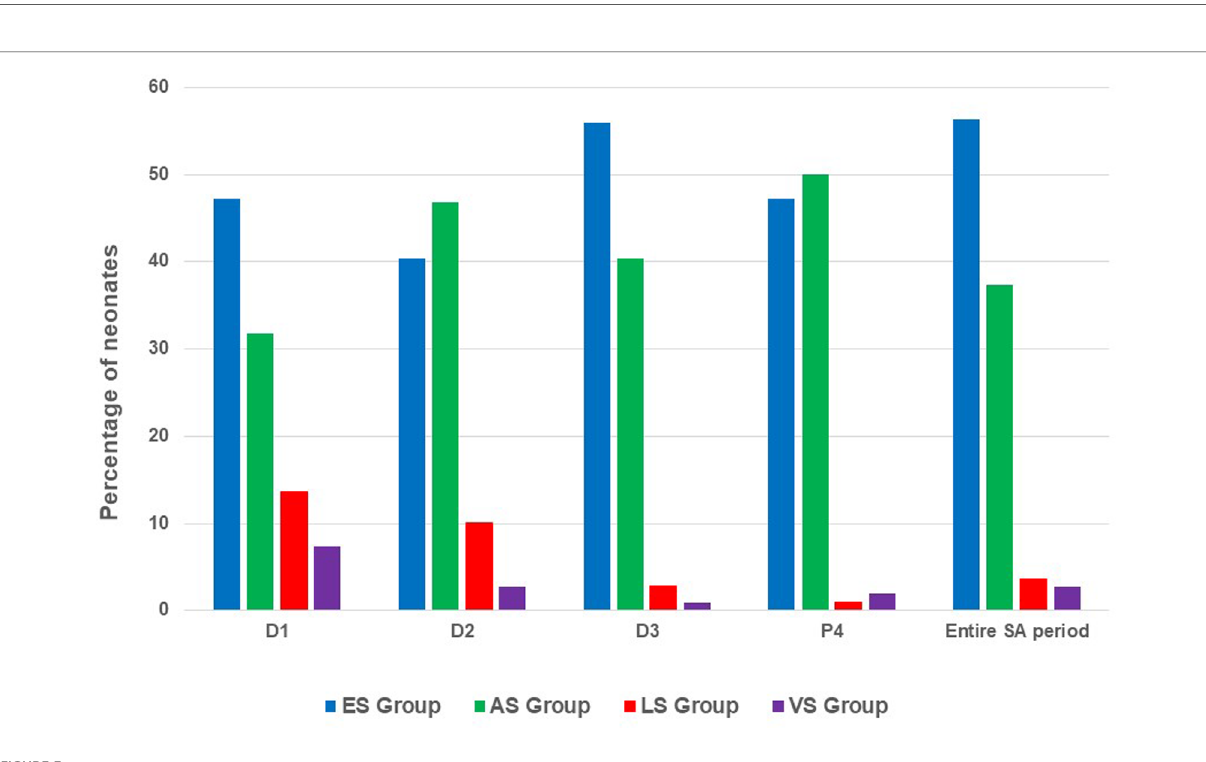
FIGURE 3 Distribution of wellbeing of neonates. ES, excess SA; AS, adequate SA; LS, lack of SA; VS, variability of SA; SA, sedation